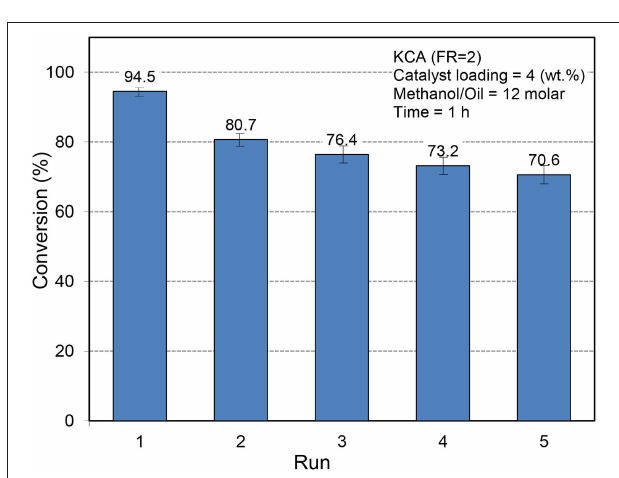
FIGURE 9 | Reusability of KOH/Ca 12 Al 14 O 33 nanostructured catalysts toward biodiesel production from canola oil.